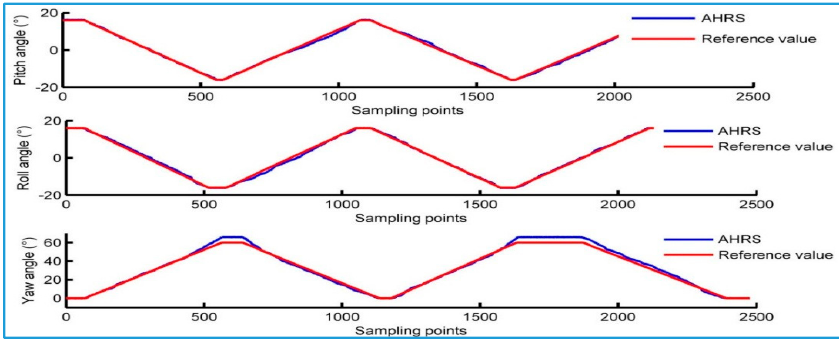
Figure 12. Comparison between output of AHRS and reference values.